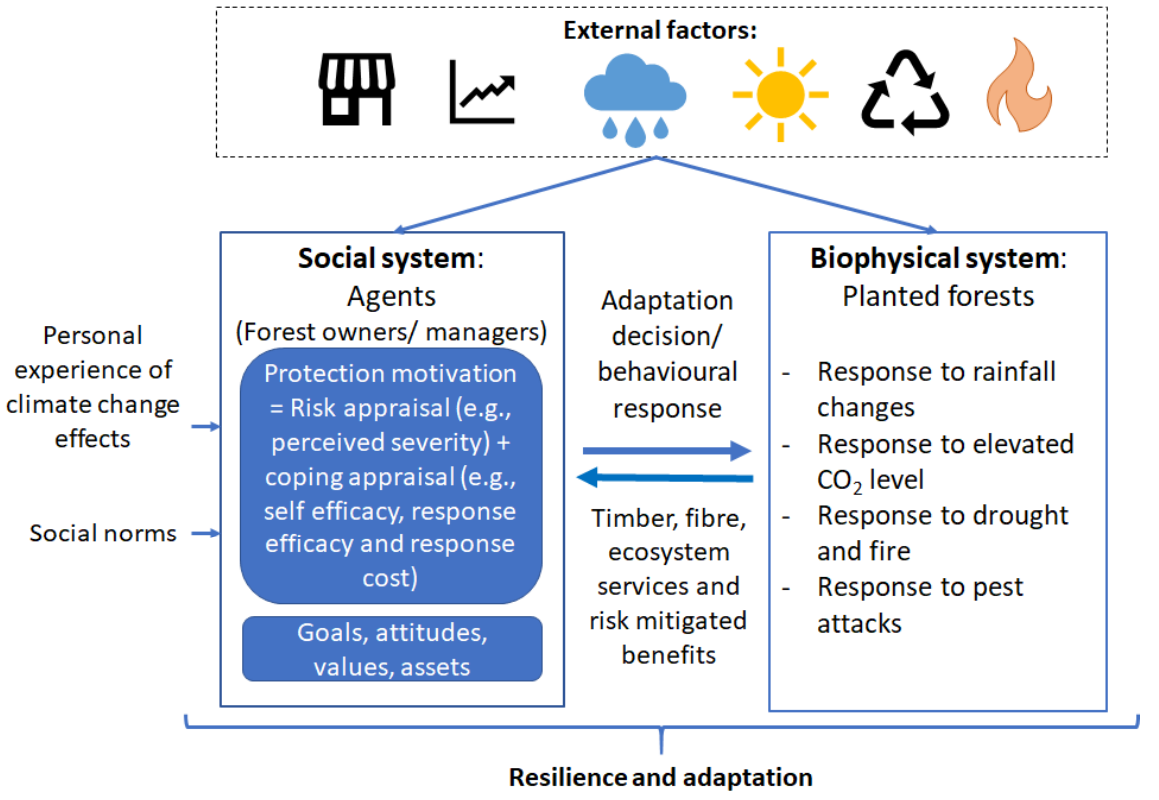
Figure 1. Proposed conceptual framework integrating the PMT framework for improving agents’ adaptation behaviour.